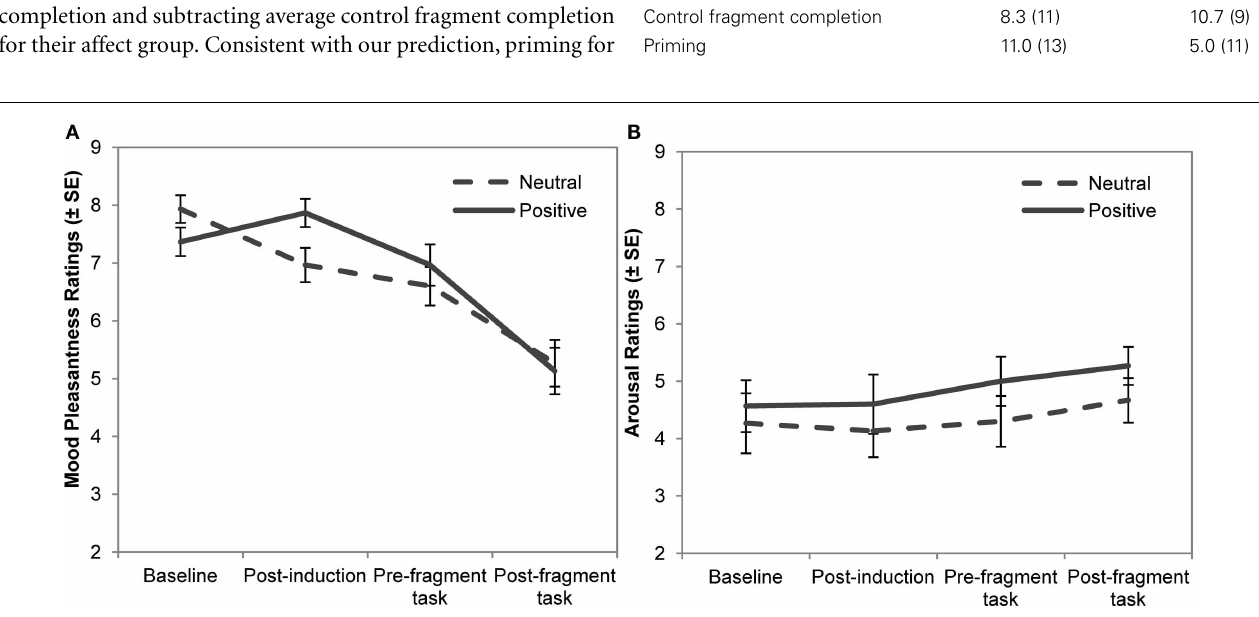
FIGURE 1 | Ratings made at various points during the experiment for (A) mood pleasantness, and (B) arousal. Error bars indicate standard error of the mean.